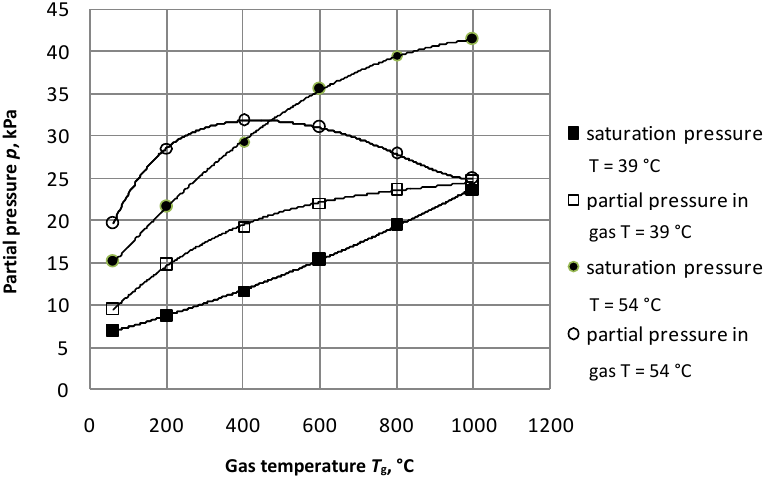
Fig. 5. Alterations of partial pressure in the heat